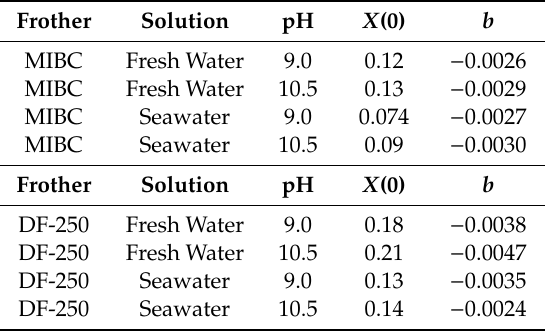
Table 2. Constants of Method 3 for MIBC and DF-250 at di ff erent pH, and in fresh and